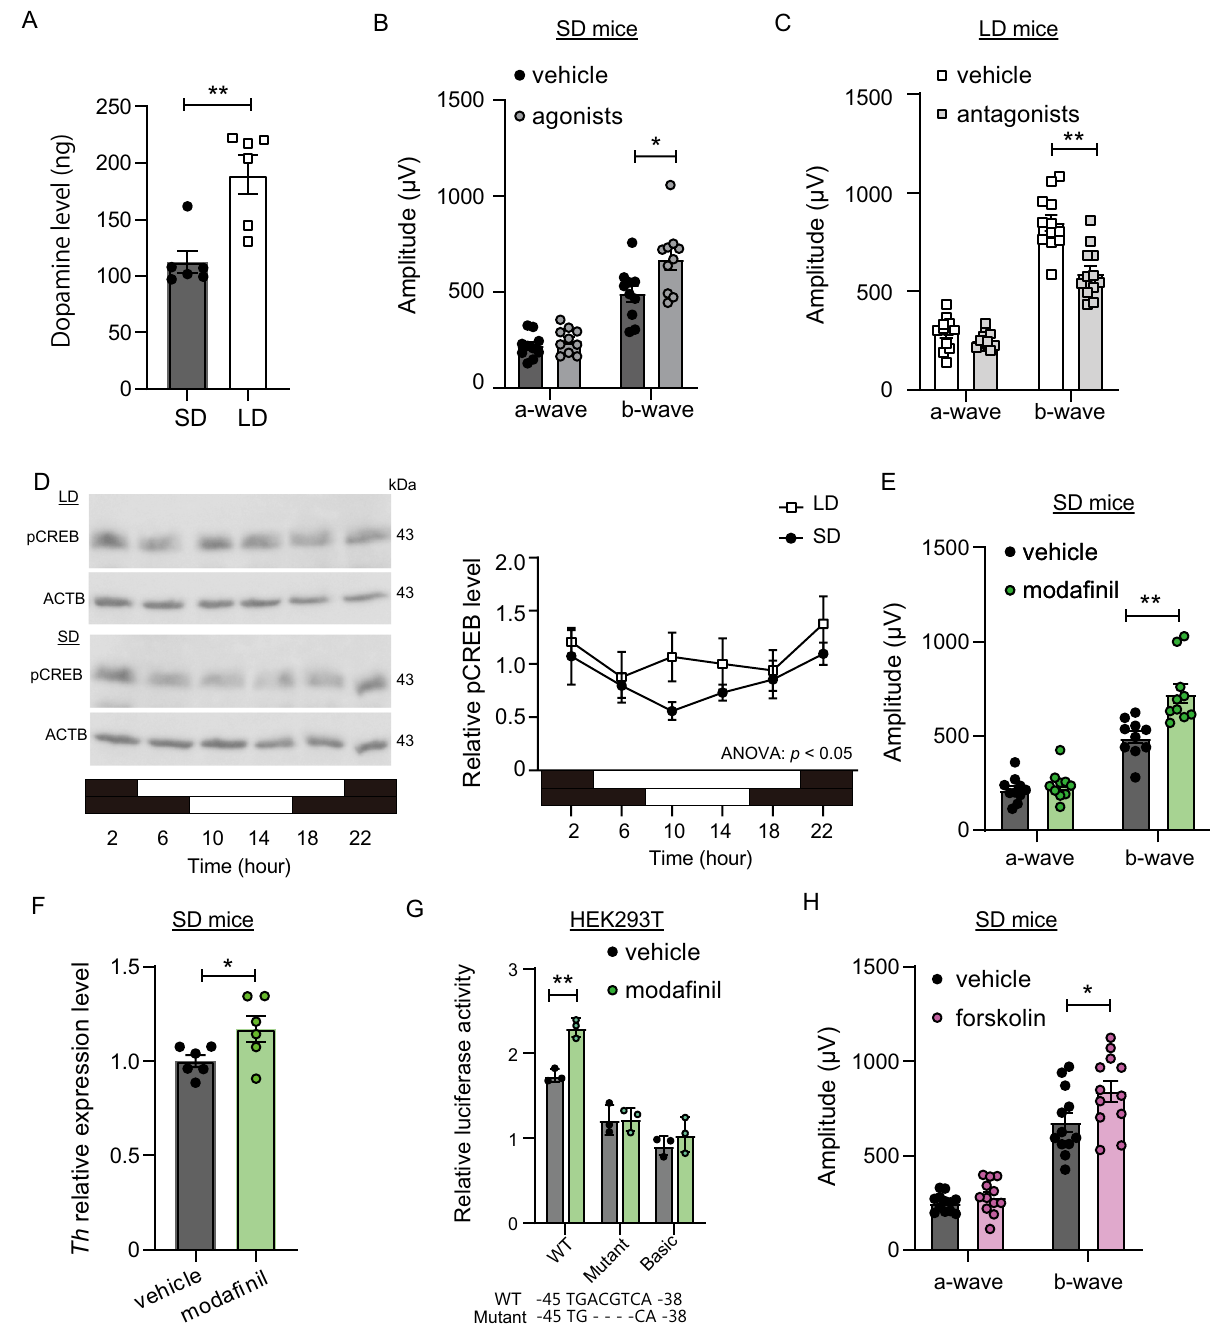
Figure 3. Pharmacological intervention of dopamine signaling regulates mesopic b-wave amplitude. ( A ) Increase in dopamine in the eyes of mice by long-day conditions measured by ELISA. (Student’s t -test, t (10) = 3.943, ** p = 0.0028, mean ± SEM, n = 6). ( B ) Effect of dopamine receptor (D1/D4) agonist cocktail on mesopic ERG responses in SD mice (Student’s t -test, t (18) = 0.9807 [a-wave], t 18 = 2.520 [b-wave], * p = 0.0214 mean ± SEM, n = 10). ( C ) Effect of dopamine receptor (D1/D4) antagonist cocktail on mesopic ERG responses in LD mice (Student’s t -test, t (22) = 1.386 [a-wave], t (22) = 4.676 [b-wave], ** p < 0.01, mean ± SEM, n = 12). ( D ) Western blotting for pCREB and ACTB in eyes of SD and LD mice (left). Relative pCREB value was normalized against ACTB level (right) (two-way ANOVA, effect of photoperiod, F (1, 24) = 4.353, p = 0.0477; effect of time, F (5,24) = 1.803, p = 0.1503; effect of interaction, F (5,24) = 0.8554, p = 0.8554, mean ± SEM, n = 3). To quantify band intensity, three different gels were used (see Supplementary Fig. 3). ( E ) Effect of modafinil on mesopic ERG responses in SD mice (Student’s t -test, t (18) = 0.7161 [a-wave], t (18) = 3.855 [b-wave], ** p = 0.0012, mean ± SEM, n = 10). ( F ) Effect of modafinil on Th expression level measured by qPCR (Student’s t -test, t (10) = 2.266, * p = 0.0469, mean ± SEM, n = 6). ( G ) Promoter activity of mouse Th was measured using HEK293T cells. Wild-type and mutant reporters fused to the luciferase gene were assayed for their activities in response to modafinil. CRE sequences of wild type (WT) and mutant (Mutant) are shown at bottom. Basic: pGL4.19-basic empty vector. (Student’s t -test, t (4) = 7.199 [WT], t (4) = 0.06143 [Mutant], t (4) = 0.9412 [Basic], ** p = 0.0020, mean ± SEM, n = 3) ( H ) Effect of eyedrop topical administration of forskolin on mesopic ERG responses in SD mice (Student’s t -test, t (22) = 1.145 [a-wave], t (22) = 2.181 [b-wave], * p = 0.0402, mean ± SEM, n = 12). Mesopic ERG was measured using a − 1.0 log(cds/m 2 ) light